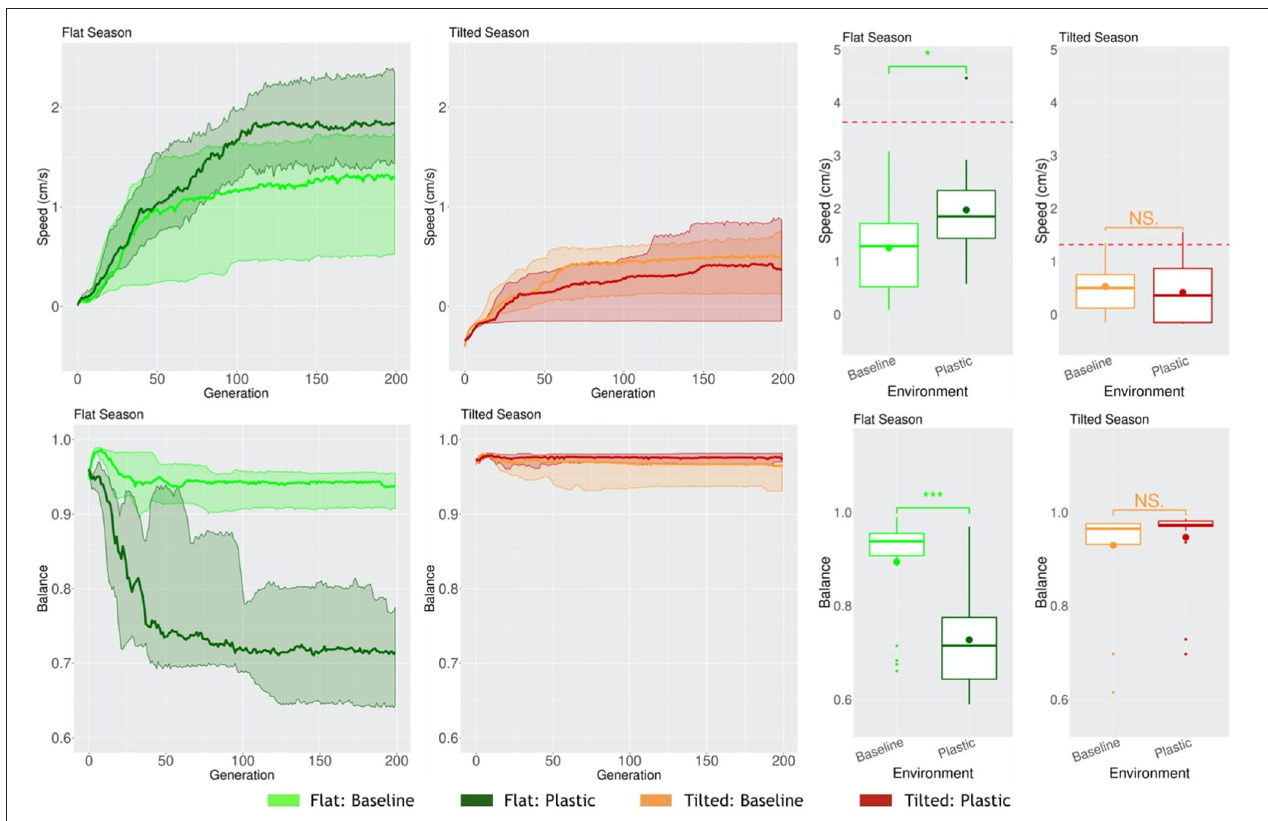
FIGURE 13 | Comparison of behavioral properties in different environmental conditions. Line plots show the progression of the means of the population (quartiles over all runs), while boxplots show the distribution of the means in the final generation. Significance levels for the Wilcoxon tests in the boxplots are ∗ < 0.05, ∗ ∗ ∗ < 0.001, NS not significant. The red dotted lines represent the mean Speed when evolving in a static environmental condition.